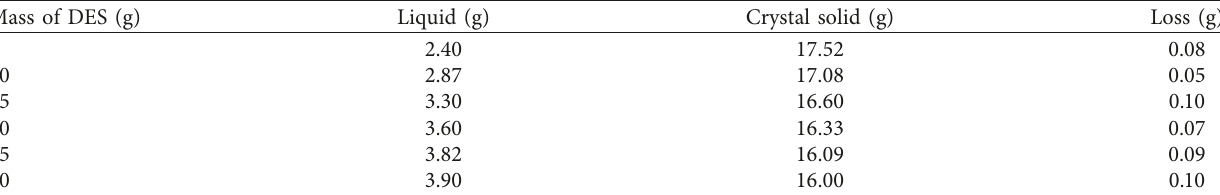
Figure 6: (a) DES and methanol extract; (b) DES, methanol extract, and methyl ester after stirring and heating; (c) mixture after 8 hours of cooling; (d) omega-rich fatty acids in the liquid layer; (e) crystal solid under the microscope; (f) fatty acids separated from crystal solid. Table 5: The dependence of the liquid/crystal solid ratios on mass of DES.